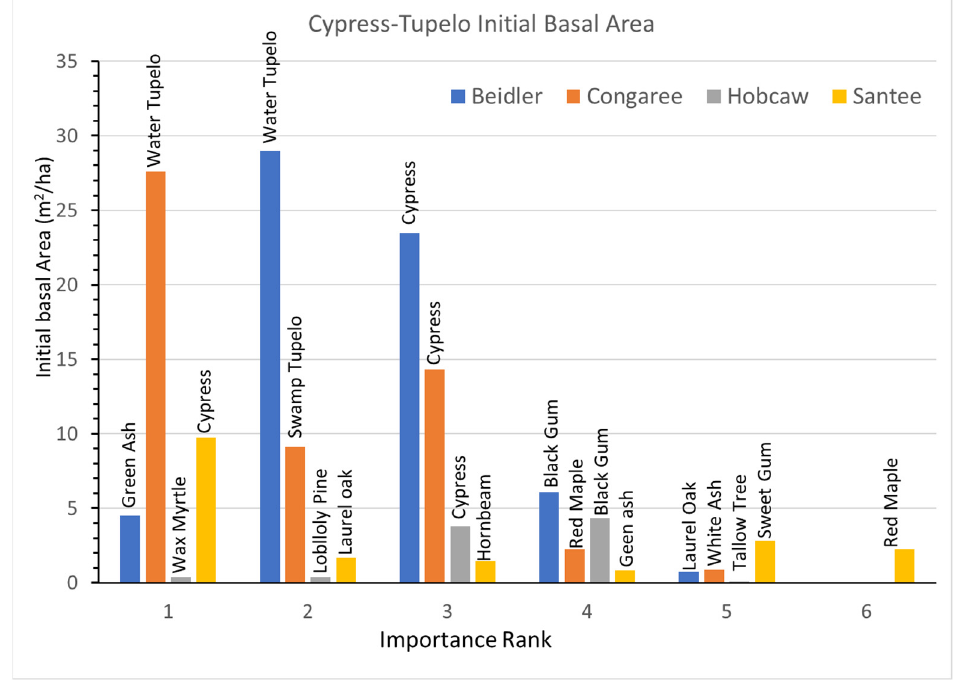
Figure 5. Distribution of initial basal area of each species, by importance rank (1 means the most important, while 6 means the least important) for each study site of the cypress-tupelo vegetation type. The initial BA (Figure 3) indicated that there were only a few small changes